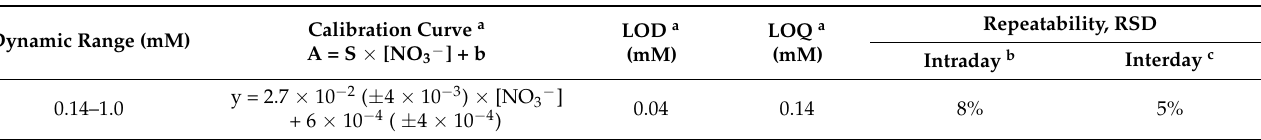
Table 2. Features of the developed µ PADs for the determination of nitrate; LOD, limit of detection; LOQ, limit of quantification; RSD, relative standard deviation. Dynamic Range